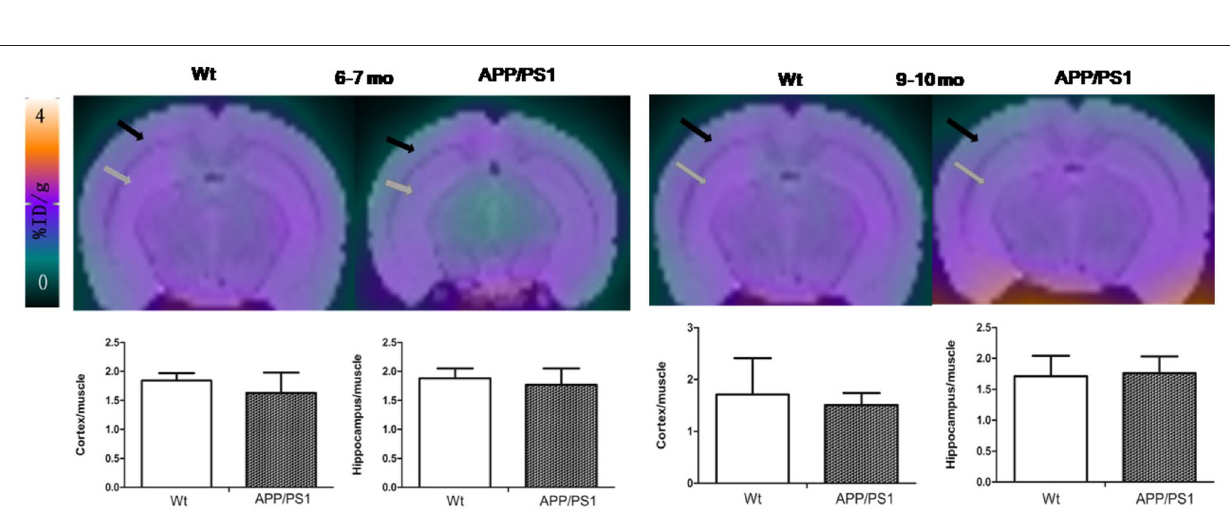
Frontiers in Neuroscience | www.frontiersin.org